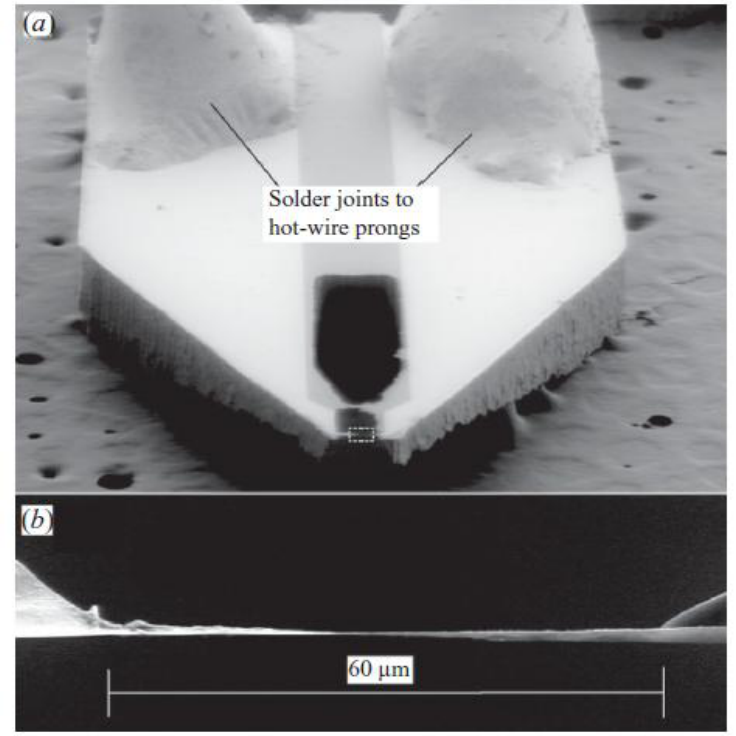
Figure 7. Pt nanoscale suspended wire for hot-wire thermal flow sensing